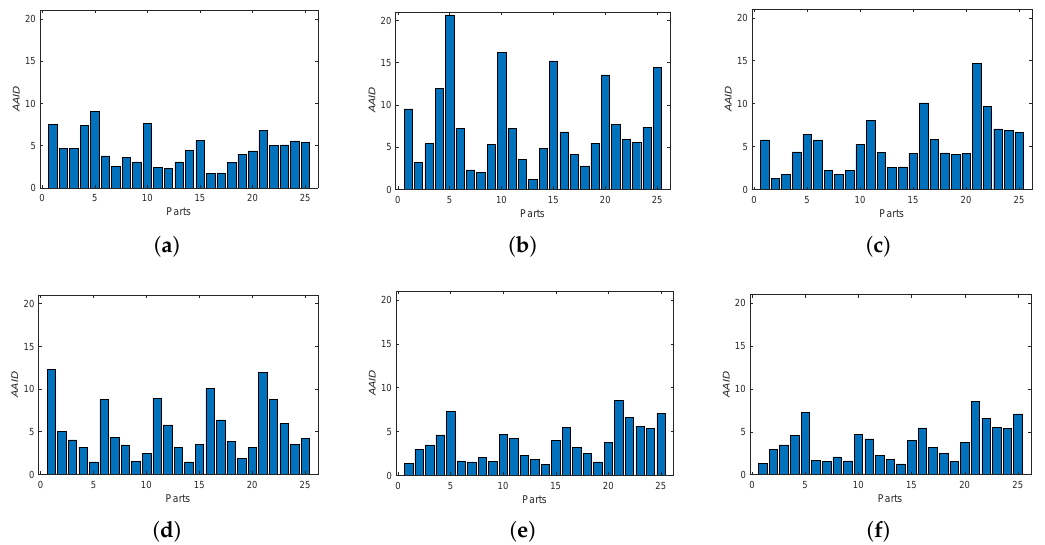
Figure 16. Spatial partition of the AAID evaluation for West Concord image. ( a ) BRISK. ( b ) KAZE. ( c ) SURF. ( d ) RANRESAC. ( e ) Proposed (Demp). ( f ) Proposed(PCR6).